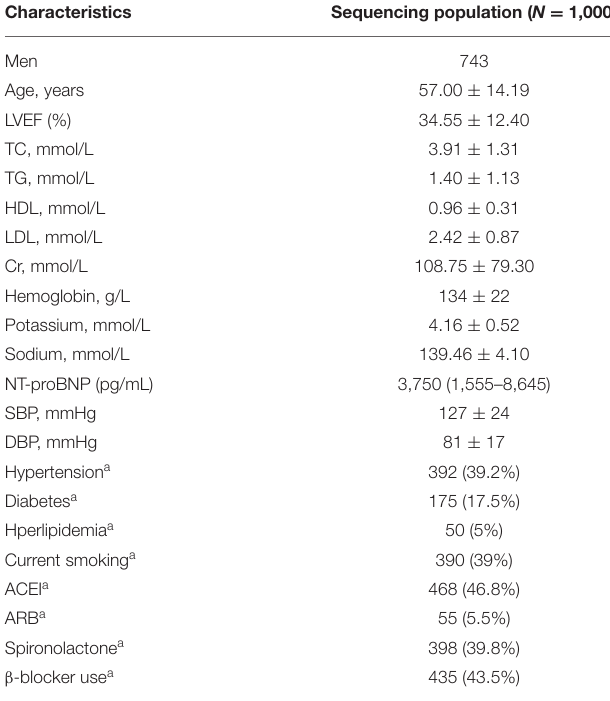
TABLE 1 | Baseline characteristics of population with whole exome